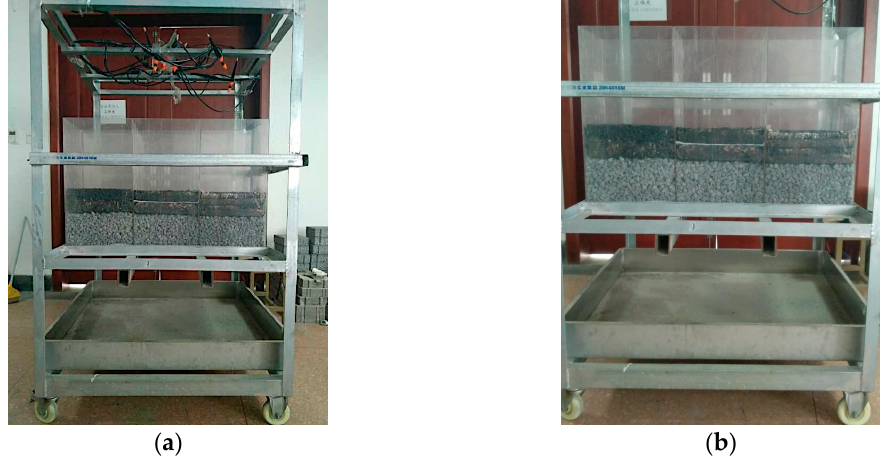
Figure 3. The artificial rainfall system used in this study: ( a ) The artificial rainfall system with installed model PA pavements; and, ( b ) Model PA pavements installed in the test rigs.